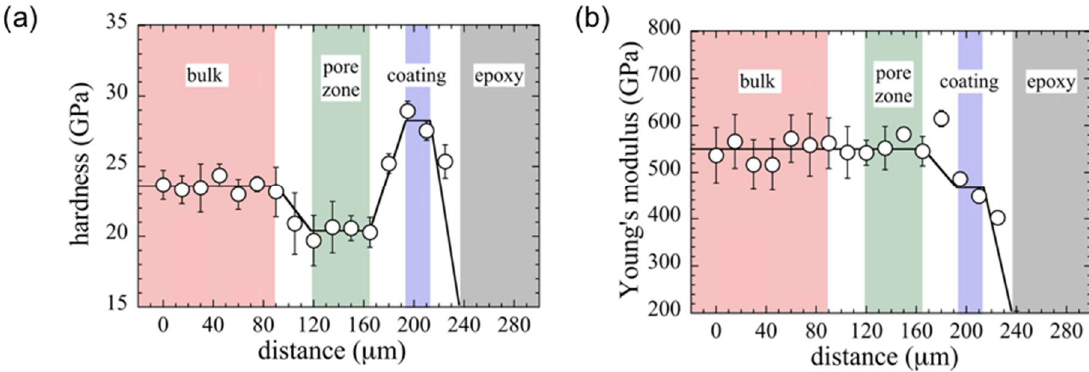
Figure 9. Evolution in hardness ( a ) and Young’s modulus ( b ) into the coating depth. Error bars represent the standard deviation of at least five nominally identical indents.